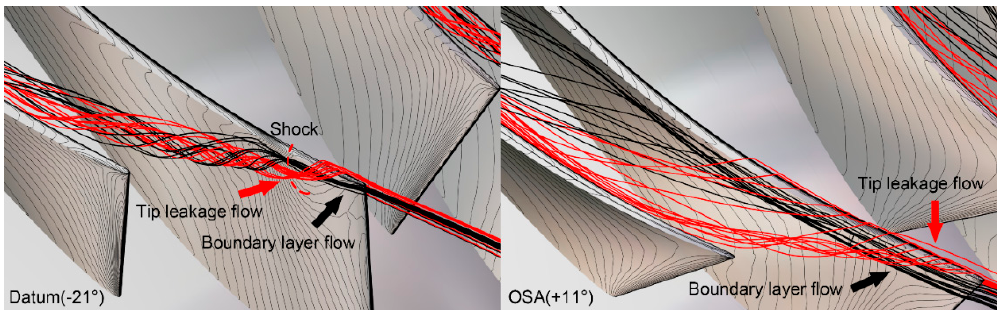
Figure 20. 3D tip streamlines and static pressure isolines on main blade and splitter I.